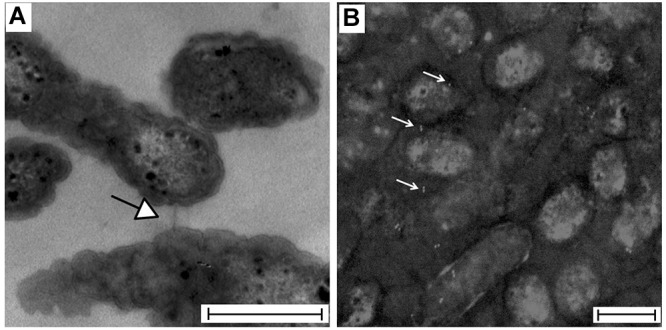
Visualization of A. ferrooxidansTY cells by transmission electron microscopy. (A) TEM preparation showing an intercellular channel connecting two bacteria. (B) Immunogold showing positive signal for pilin (white) intercellularly or on the bacterial surface of Mitomycin C-treated cells (gray scale). Bar: 500 nm. The image was black-white inverted to improve the contrast.